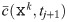
Illustration of the local no-wait condition.The decision to wait at vertex vk or immediately move to vertex vℓ is based on the future threat field values c¯(xk,tj+1), c¯(xℓ,tj+1), c¯(xℓ,tj+2), and waiting and movement costs αw and αm.